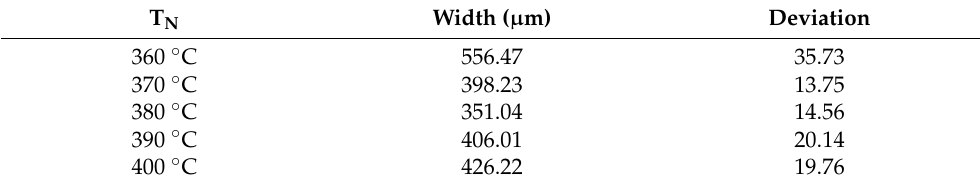
Table 1. Width and deviation of nozzle temperature.